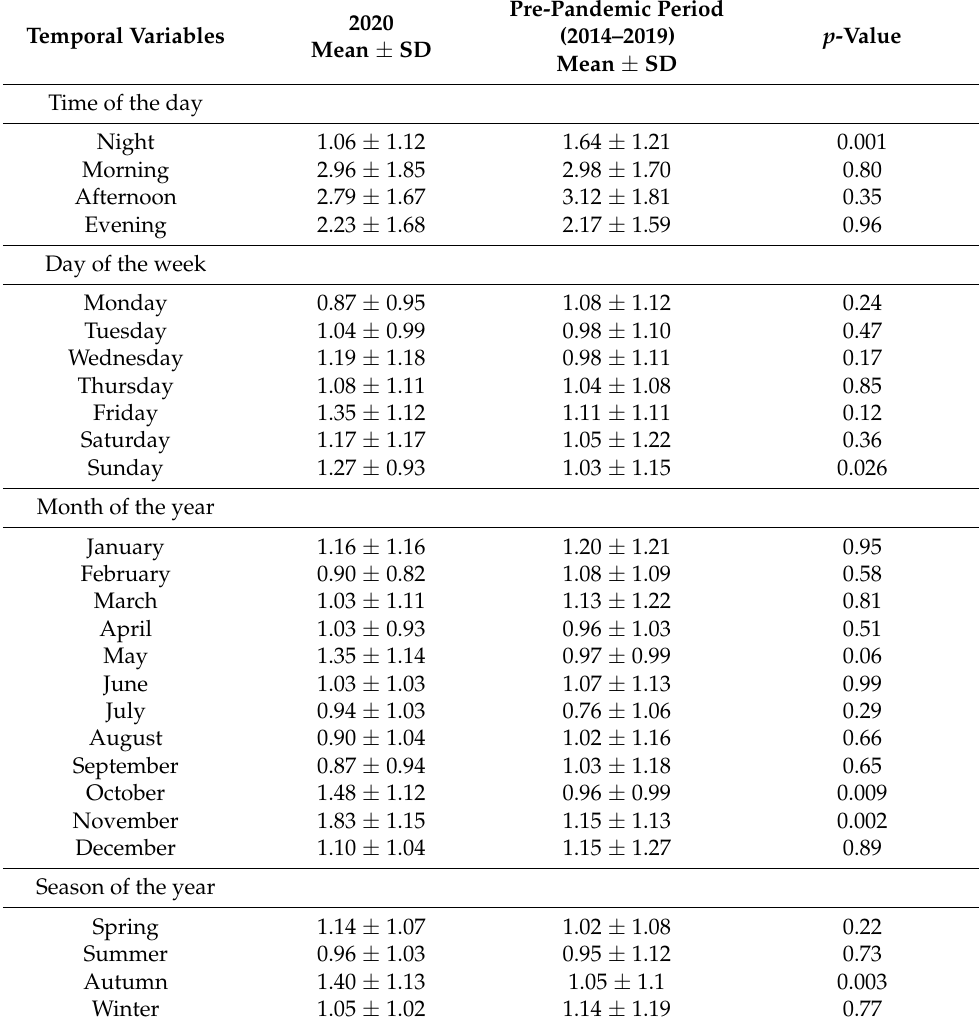
Table 1. Comparison of differences in temporal variability of OHCA occurrence between pre- pandemic period and year